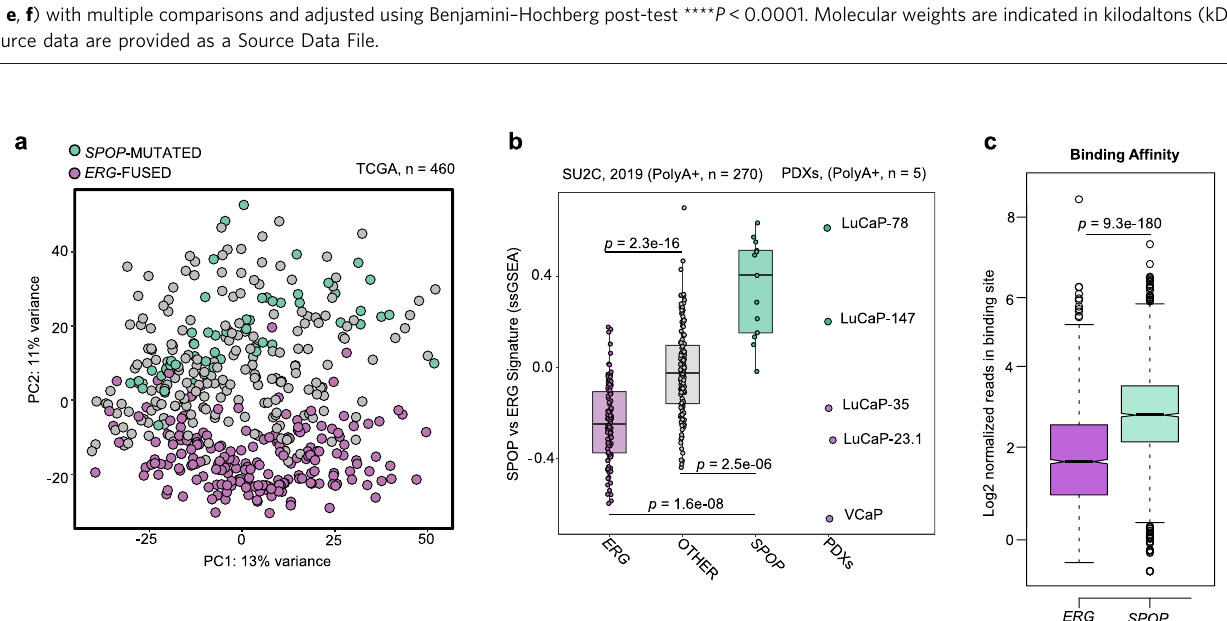
Fig. 2 Transcriptome analysis of primary prostate cancer patients reveals major differences between SPOP mutant and ERG -fused tumor subtypes. a PCA-analysis based on RNA-Seq derived mRNA expression levels (TCGA cohort). ERG -fused (violet) and SPOP -mutant (green). Individuals were annotated into subtypes as described in Material and Methods. b Boxplots representing the transcriptional activity of SPOP integrated-signature (see Materials and Methods) applied to CRPC samples (SU2C-2019 cohort, left) and PDX-models. Scores are determined genes-signatures derived from primary prostate tumors (TCGA-cohort). ERG-fused samples are depicted in violet, SPOP-mutant samples are depicted in green. Samples not harboring SPOP mutations or ERG rearrangements are represented in gray. P -values were determined using Wilcoxon rank sum test and adjusted for multiple testing. Individual. (Boxplots, ERG: max = 0.22; min = − 0.75; center = − 0.31; Q2 (25%) = − 0.47; Q3 (75%) = − 0.13, OTHER: max = 0.88; min = − 0.55; center = − the number of normalized reads per binding site across all the differentially bound (DB) regions resulting from the comparison between ERG -fused (violet) and SPOP -mutant (green) samples. Analysis was restricted to DB regions showing an adjusted P -value (FDR) lower than 0.05 (as determined by DiffBind/ DESeq2 pipeline). Subsequently, signi fi cance between ERG and SPOP subgroups was assessed using Wilcoxon rank sum test. (Boxplots, ERG: max =